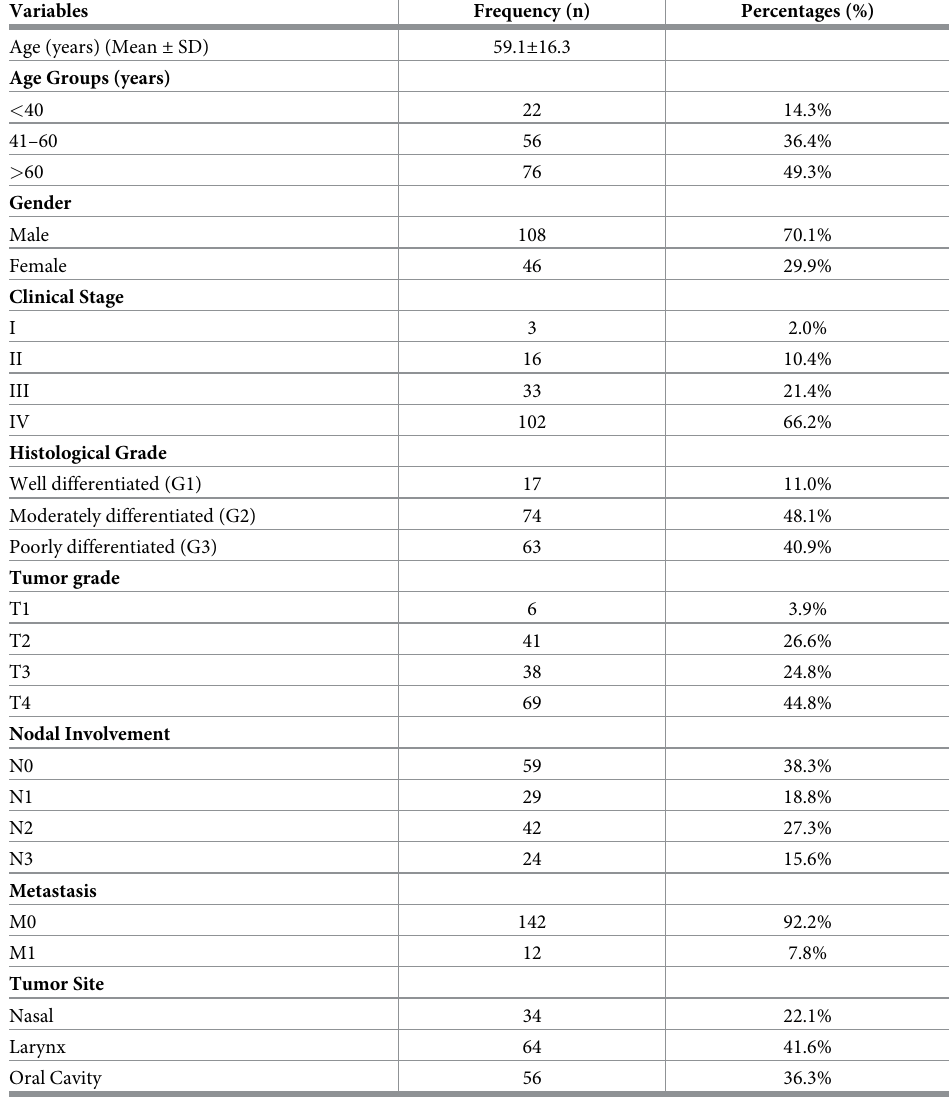
Table 1. Age, gender and clinico-pathological characteristics of the patients (n =